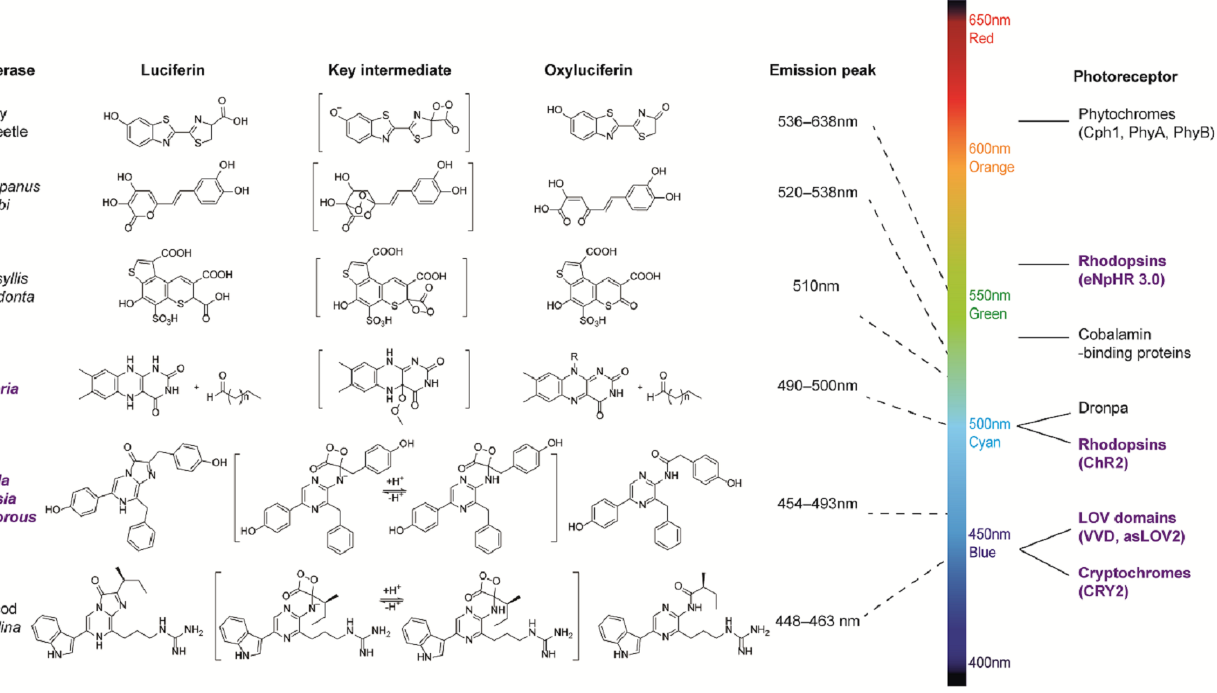
Figure 1. Bioluminescence systems and common